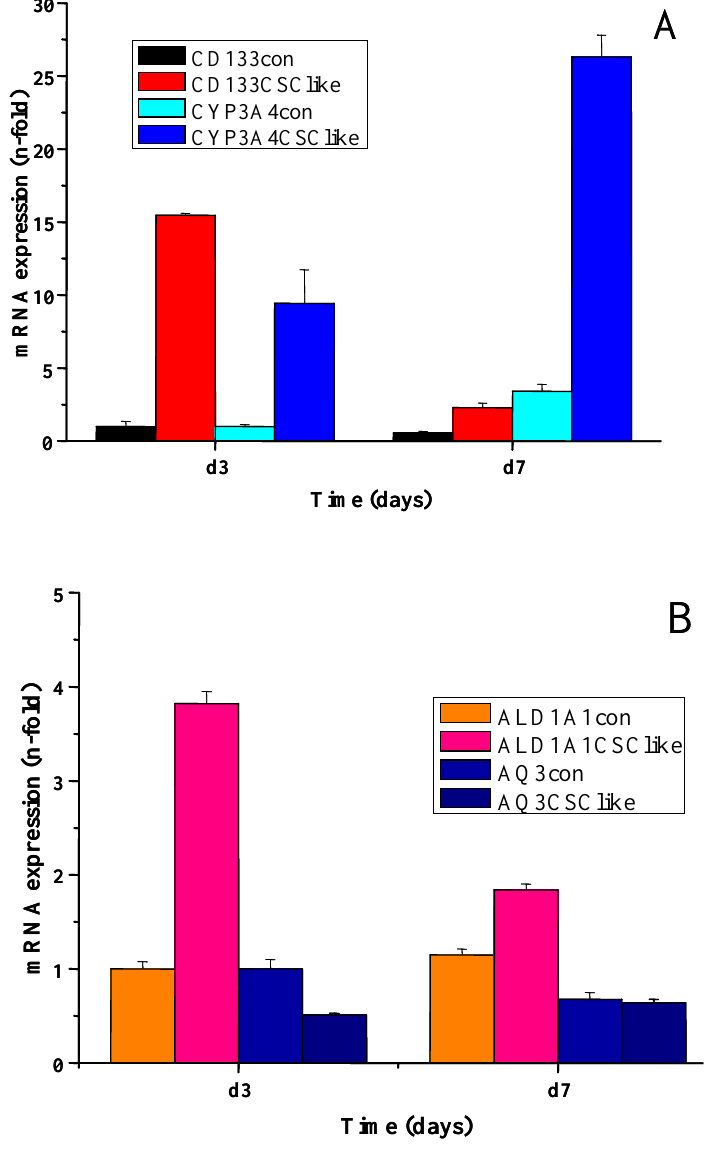
Figure 3. Assessment of gene expression levels of CD133, CYP3A4 ( A ) as well as ALDH1A1 and AQ3 ( B ) in COLO205 cells cultured in serum-free stem cell medium. Gene expression of the stem cell markers CD133 and ALDH1A1 in addition to CYP3A4 and AQ3 in COLO205 cells cultivated in either standard (con) or serum-free stem cell medium (CSClike) for three or seven days was measured by real-time qPCR (mean ±